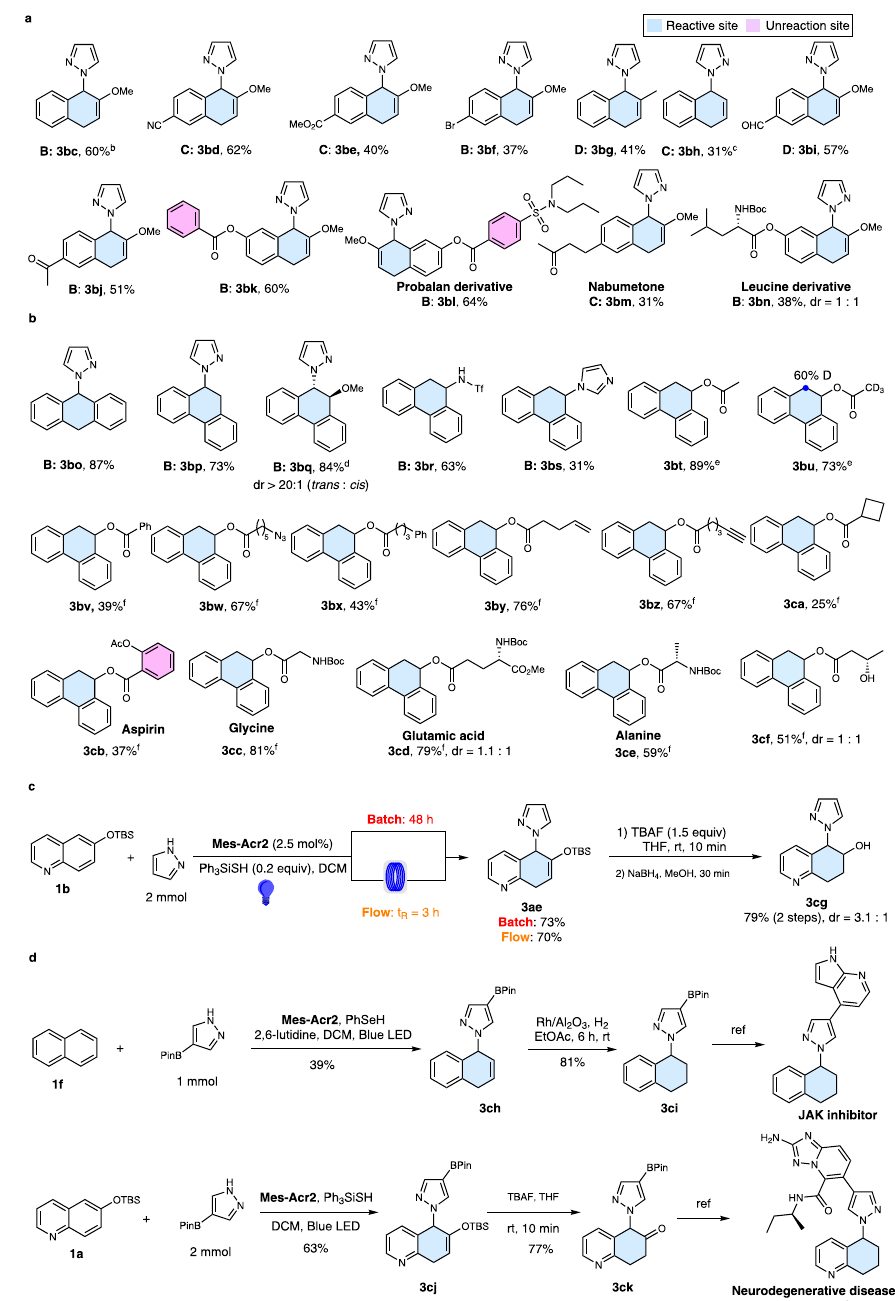
Fig. 3 | Dearomatization of fused arenes. a Scope of naphathalenes. b Scope of anthracenesandphenanathrenes. c Largescalesynthesis. d Applicationinsynthesis of valuable targets. a Reaction condition: unless speci fi ed, see footnote a of Table 1